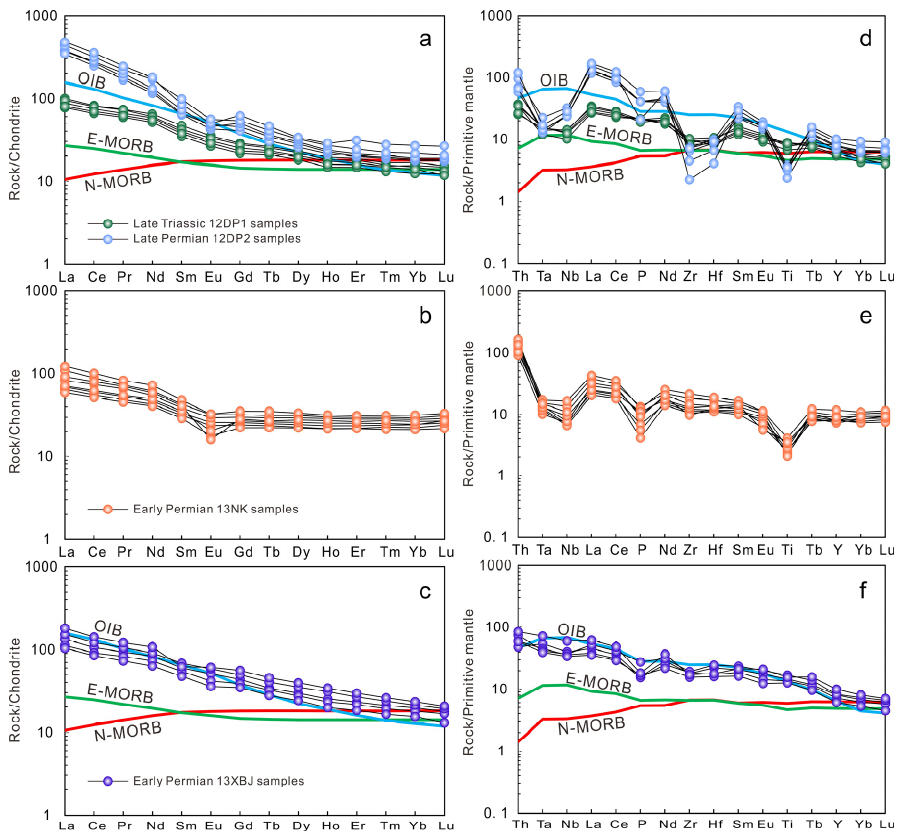
Figure 5. ( a – c ) Chondrite-normalized REE patterns and ( d – f ) primitive mantle-normalized trace element patterns of PermoTriassic metamorphic rocksin this study. Normalizing values, patterns for N-type mid-ocean ridge basalts (N-MORB), E-type mid-ocean ridge basalts (E-MORB), and oceanic island basalts (OIB) are from [ 100 ].